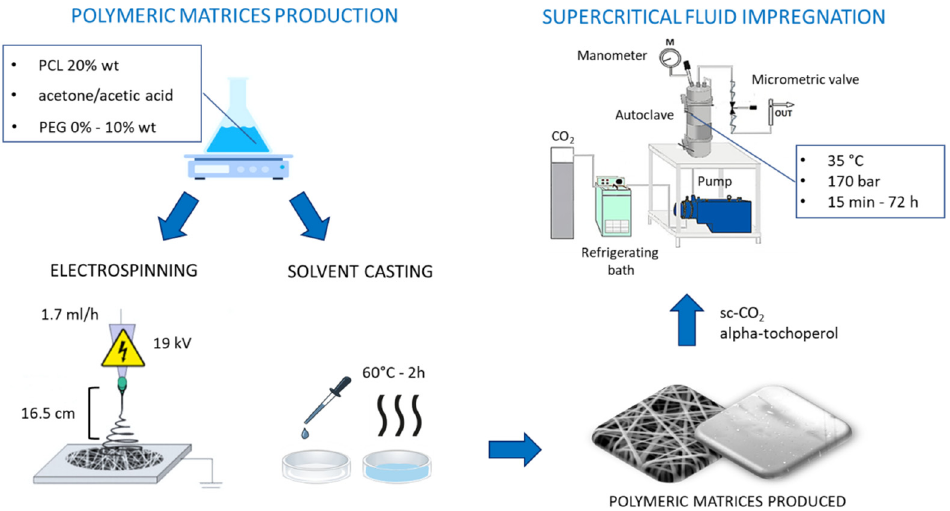
Figure 1. Scheme of the experimental steps based on different combinations of green processes: production of the polymeric matrices by electrospinning and solvent casting (left); supercritical impregnation of the supports